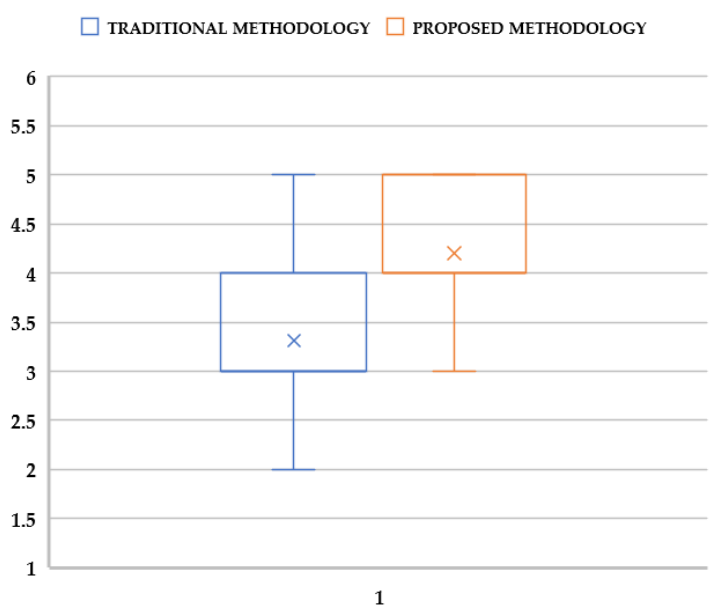
Figure 13. Distribution of exam results.